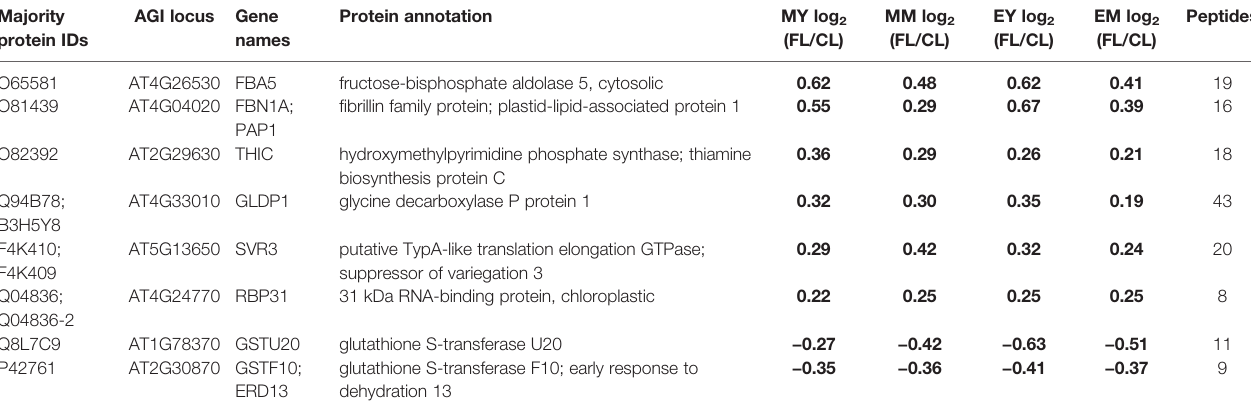
TABLE 1 | Proteins with signi fi cant changes in protein abundance in FL compared to CL in all samples (MY, MM, EY, and EM). Signi fi cant changes are indicated in bold numbers. Majority AGI locus Gene protein IDs names